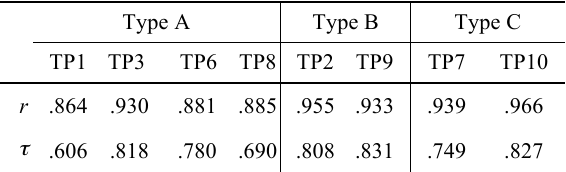
Pearson's (r) and Kendall's ( τ ) correlation coefficients between two heat measures ( NFix and NLop ) by